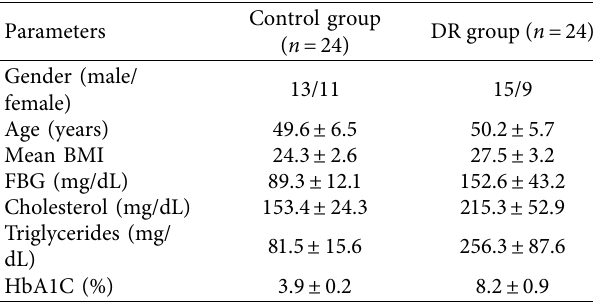
Table 1: The characteristics of DR patients and normal control